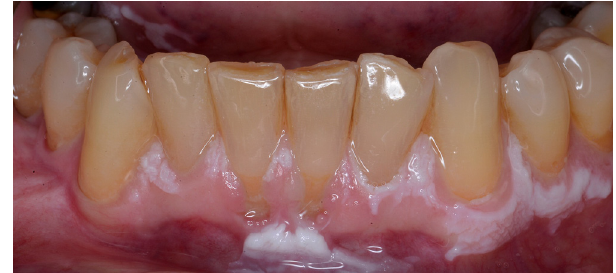
Fig. 4. Proliferative verrucous leukoplakia involving the marginal gingival of the lower anterior labial gingiva and lower lingual sulcus (image provided by Guy ’ s and St Thomas ’ ).